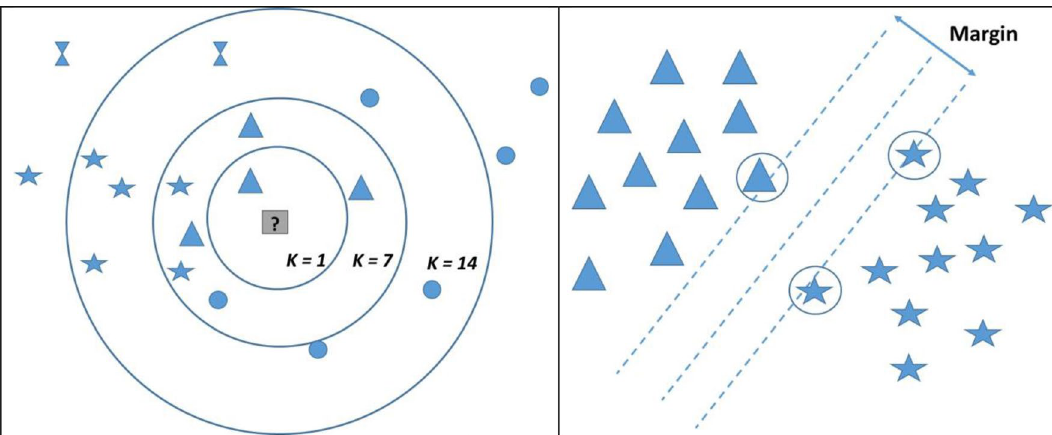
Figure 10. Left: A simplified, schematic drawing, showing a feature distance space and the classification process based on the nearest neighbors classifier. Given k = 1, the query image (question mark) is assigned to the label triangle. Right: A simplified, schematic drawing, showing the process of SVM classification. In multidimensional feature space, SVM finds the hyperplane that maximizes the margin between the classes (here two classes). Here, the support vectors are the circled